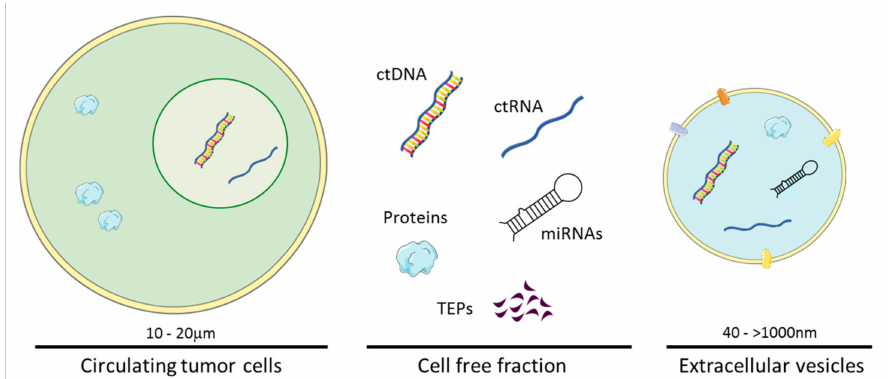
Figure 1. Components found in liquid biopsy (blood or cerebrospinal fluid) of glioblastoma patients. Liquid biopsies of tumor-specific circulating components include circulating tumor cells (CTCs), circulating cell-free tumor DNA (ctDNA) and RNA (ctRNA), circulating microRNAs (miRNAs), proteins, tumor-educated platelets (TEPs) and extracellular vesicles